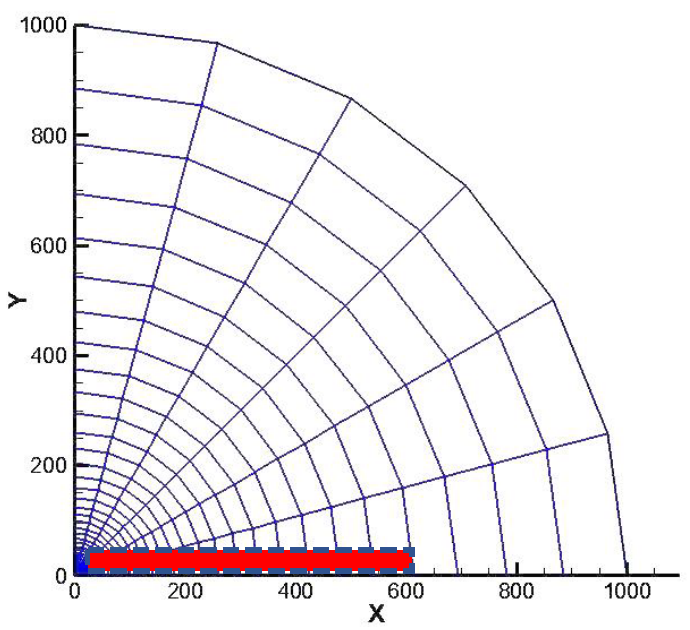
Figure 1. Schematic of the fracture reservoir used for production model.